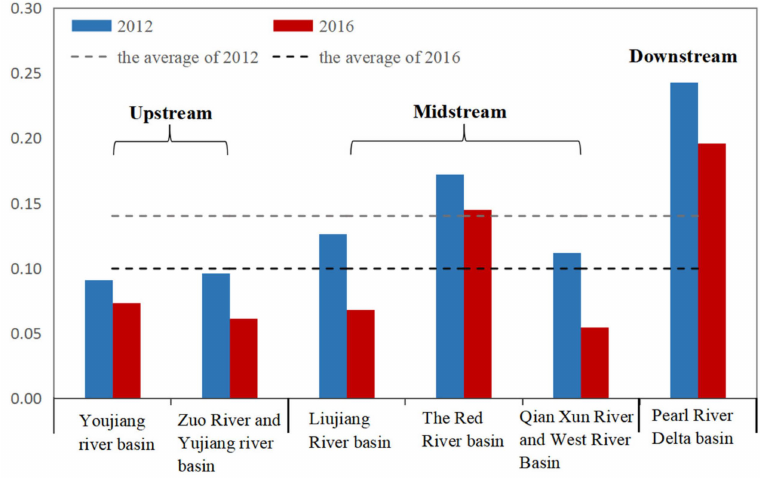
Figure 3. Changes in EPCI in different basins in the